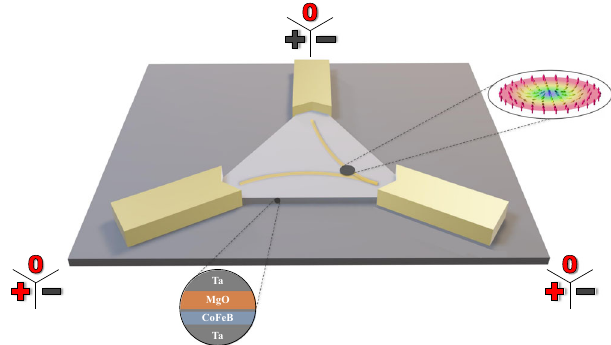
Fig. 1 | Three-dimensional schematic of the device. The stack structure is shown in the lower circle. Attached are the chromium/gold contacts, on which positive, negative, or null potential can be applied. The input values used for the present Boolean logic demonstration are highlighted in red. The dark gray spot in the triangle represents a skyrmion as imaged in our magneto-optical Kerr effect (MOKE) microscopy recordings. Here, it is pushed into the lower right corner (yellow lines represent schematically the current fl ow). The inset on the right depicts the schematic spin structure of a Néel-type skyrmion. Note: Inset adapted from the original of Karin Everschor-Sitte and Matthias Sitte, which is licensed under Creative Commons Attribution-Share Alike 3.0 Unported (CC BY-SA